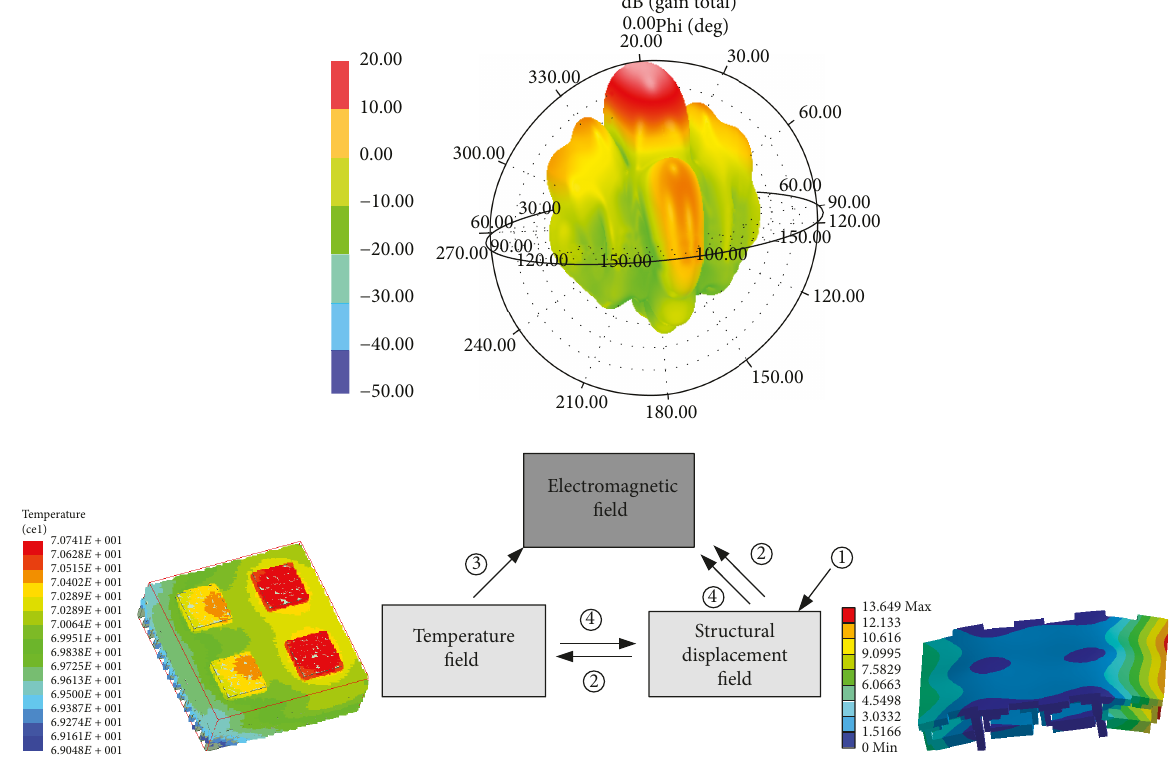
Figure 2: Three- fi eld coupling process of the AESA